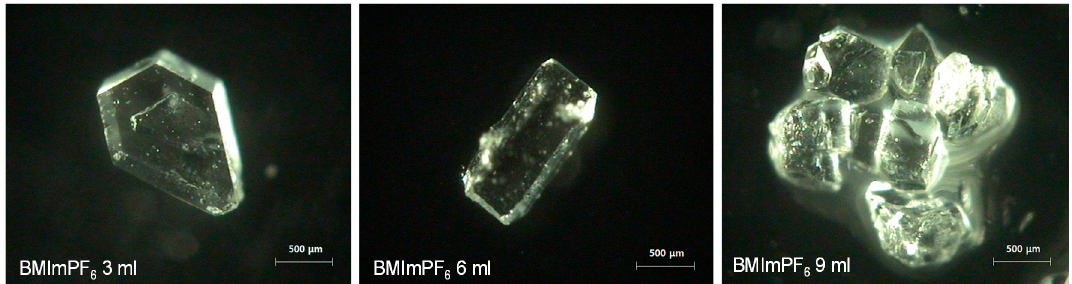
Figure 6. Video microscope images of sucrose crystals precipitated from the MeOH extraction solution of A. gigas (solvent volume of 3 mL) at varied concentrations of BMImPF 6 anti-solvent changes using crystallization techniques.